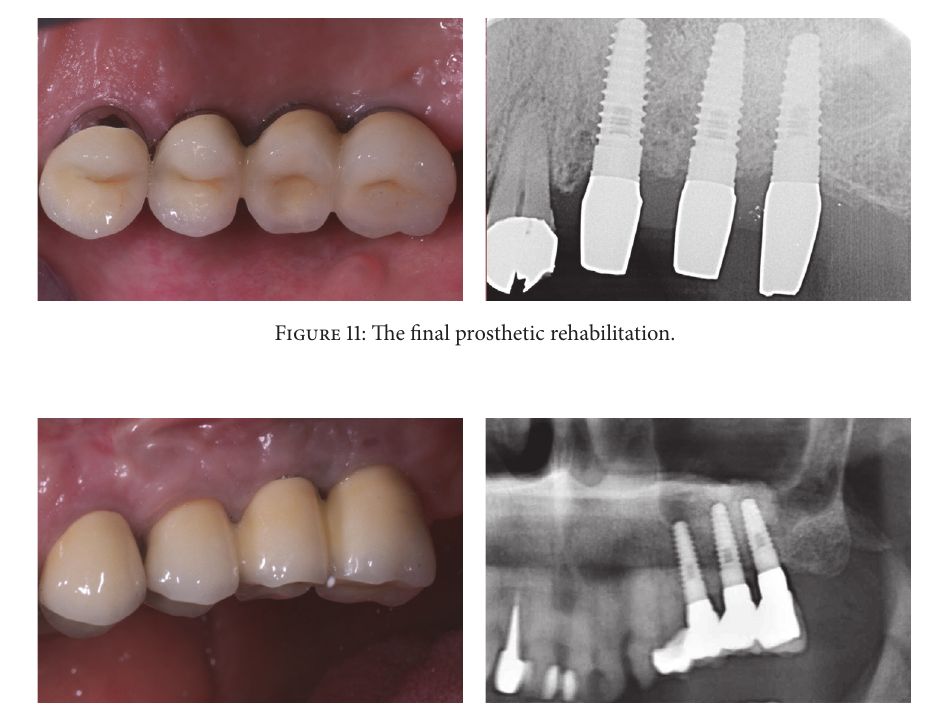
Figure 12: At the one-year control after definitive prosthetic rehabilitation, implants are successful and the prosthesis is fully